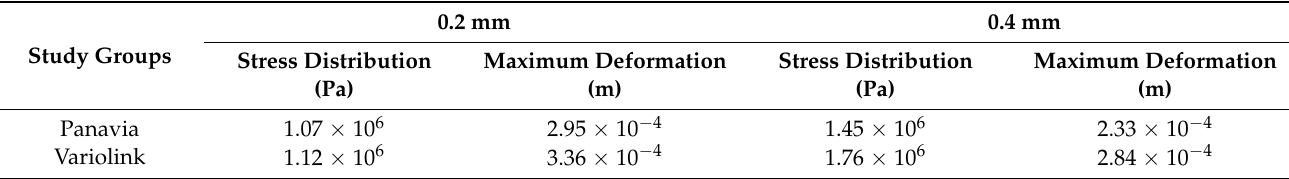
The FEA values of maximum stress and deformation are presented in Table 5. Table 5. Maximum stress and maximum deformation in cement